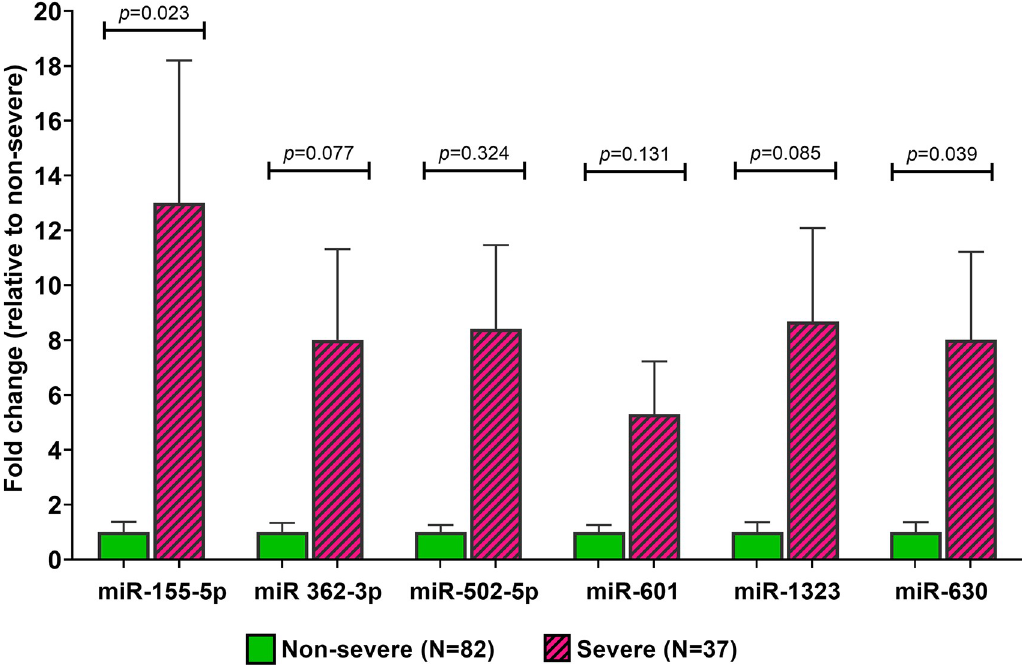
Fig 2. Relative expression of circulating microRNAs in patients with leptospirosis.